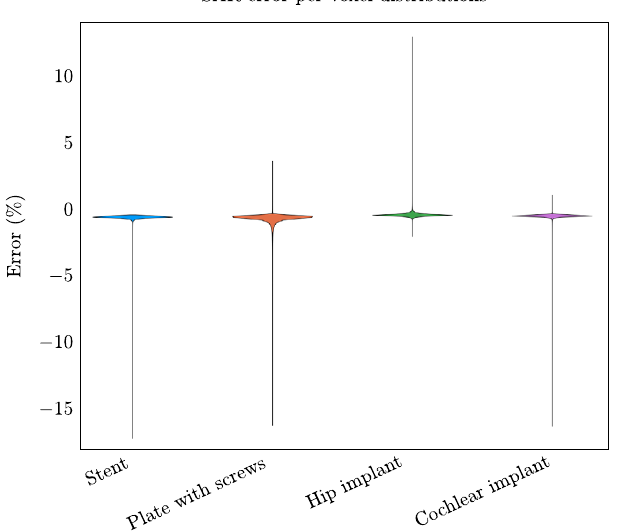
Figure 9. The percentage error distribution for every voxel around the implant. The violin plots show the distribution of the error per implant. A positive error is an overestimation of the proposed method and a negative error is an